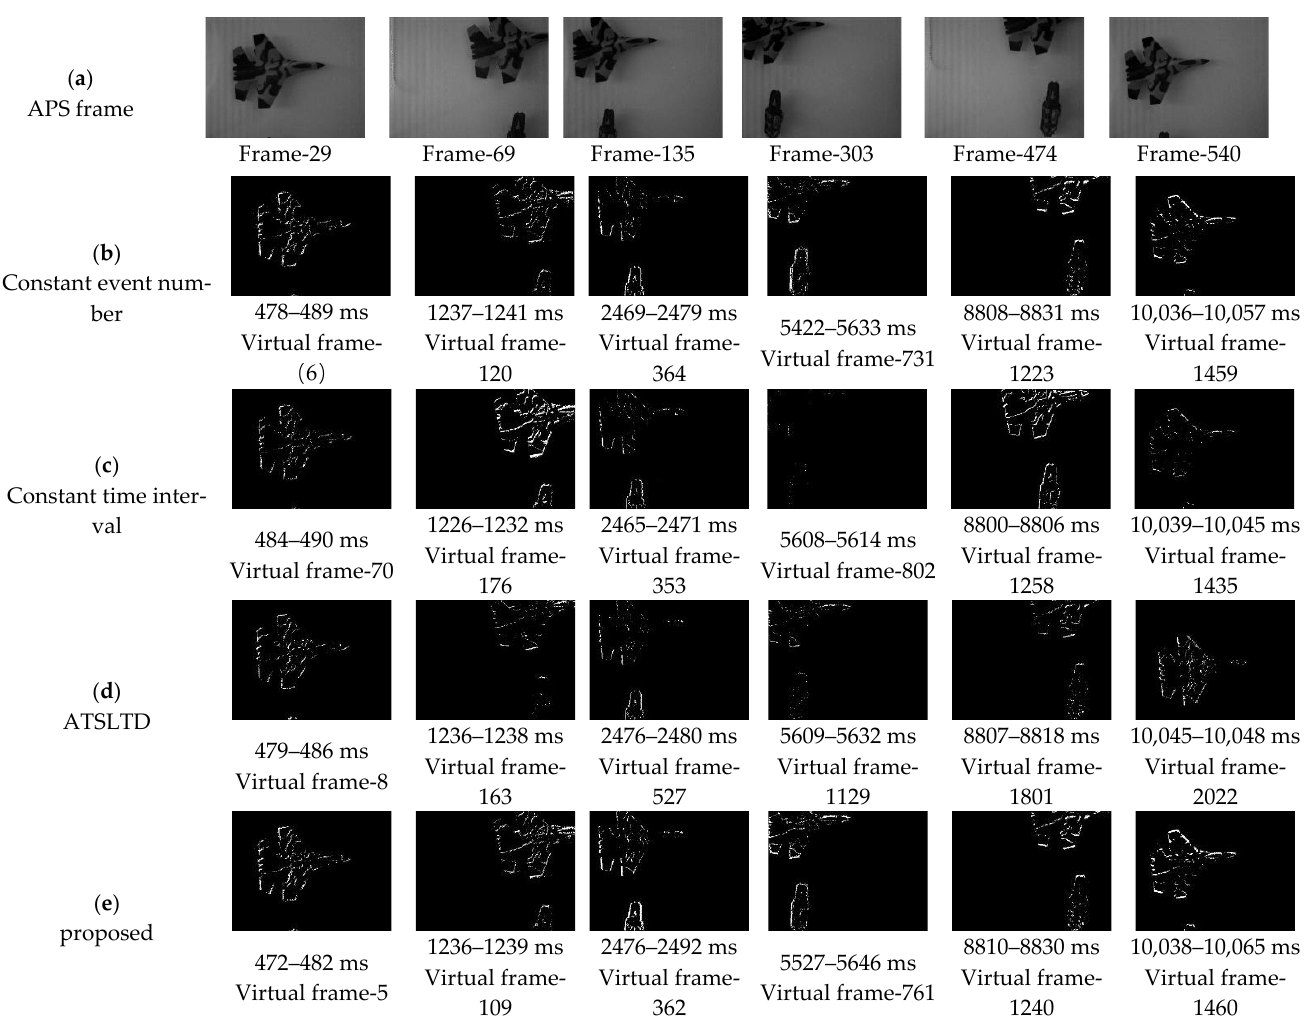
Figure 14. ( a ) APS frame; ( b ) virtual frame constructed with constant event number; ( c ) virtual frame constructed by constant time interval; ( d ) virtual frame constructed with ATSLTD; ( e ) virtual frame constructed with the proposed method.